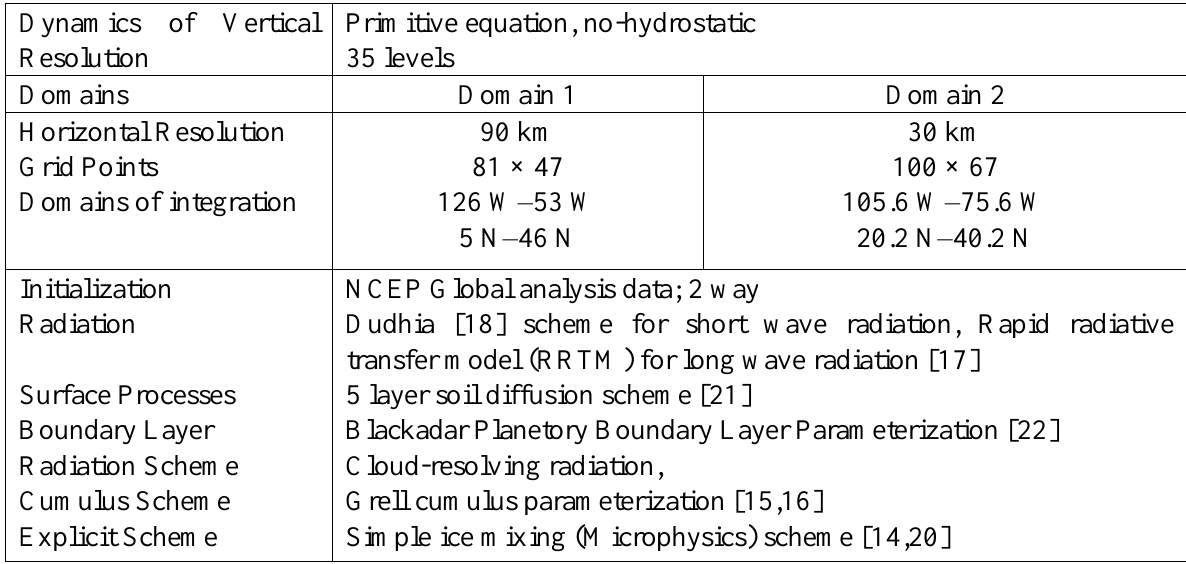
Table 1. Details of the physics and grid configuration used in WRF (ARW)